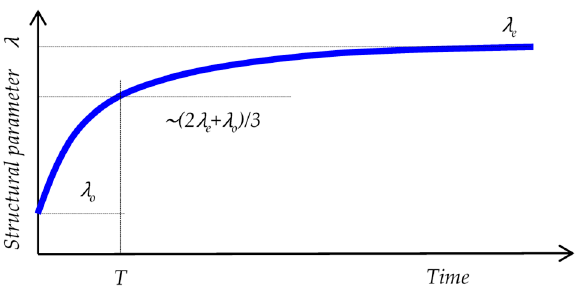
Figure 3. Schematic plot of the evolution with time of the atructure at rest according with Ma et al. [24].